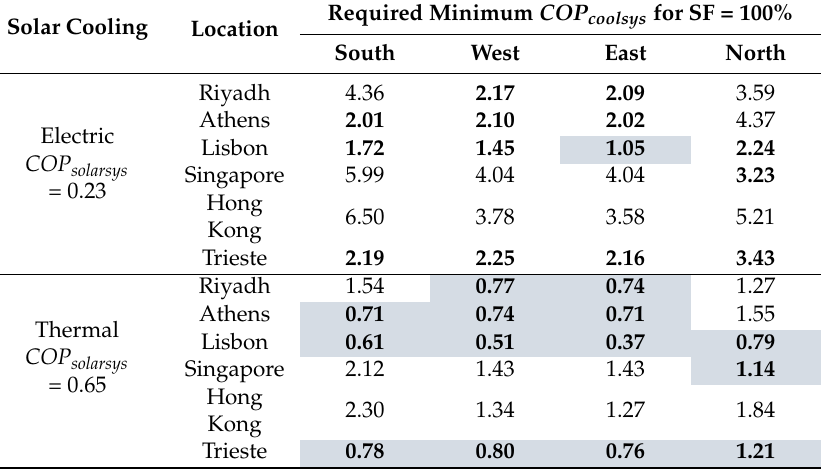
Table 6. Minimum COP values are required for a solar cooling system ( COP coolsys ) in order to reach a solar fraction of 100% per orientation and location. Solar Cooling Location South